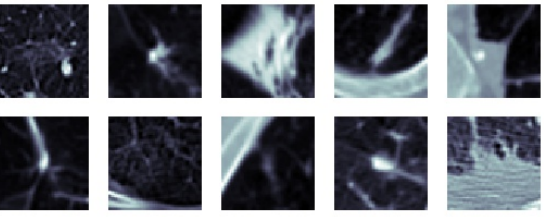
Figure 41. MFMPF model based on fusion of all—missed non-nodules (FP).